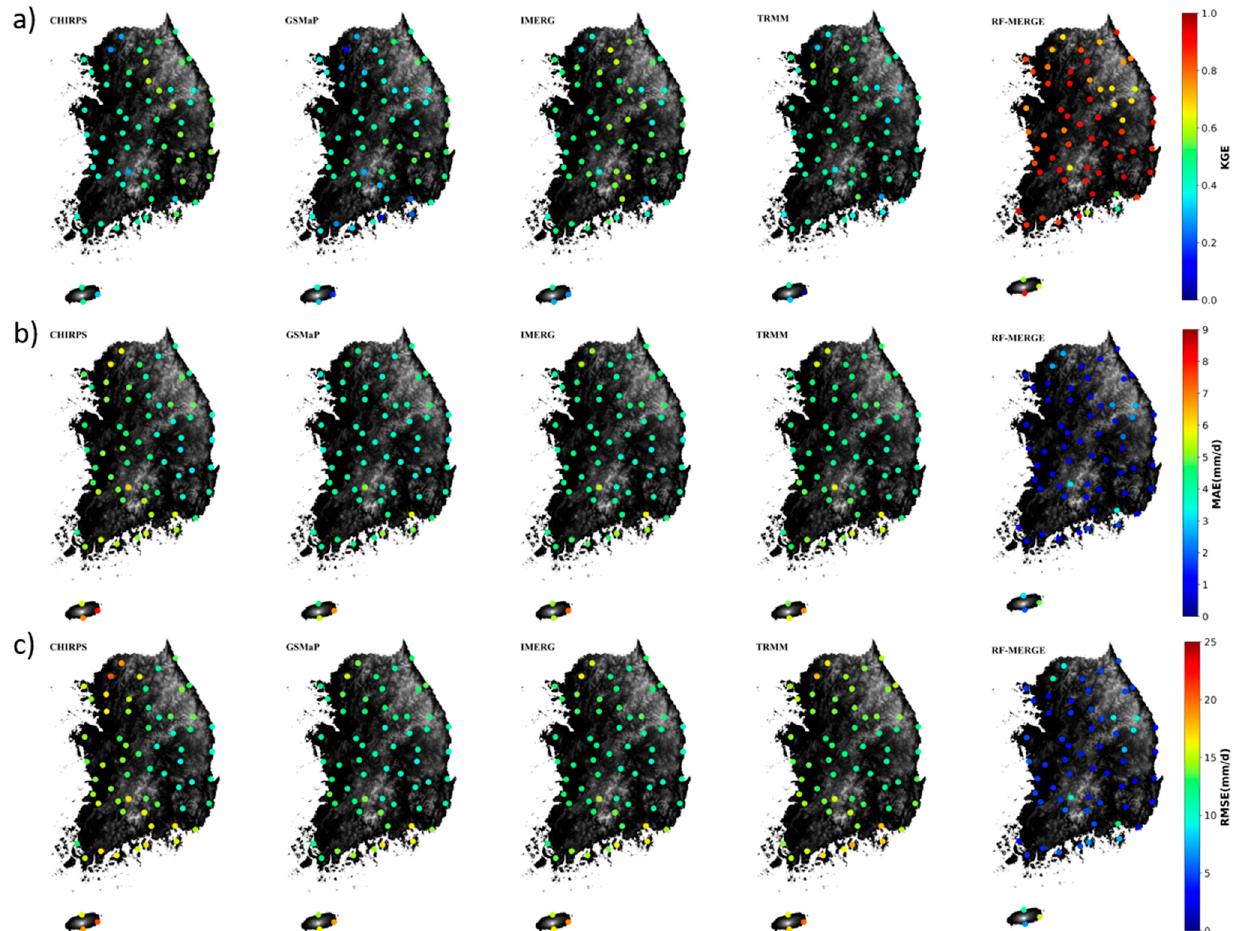
Figure 6. Evaluation of daily precipitation with four original precipitation products (CHIRPSv2, GSMaP, IMERG, and TRMM) and RF-MERGE at 64 stations by ( a ) KGE, ( b ) MAE and ( c ) RMSE during the period of 2003–2017 over South Korea.